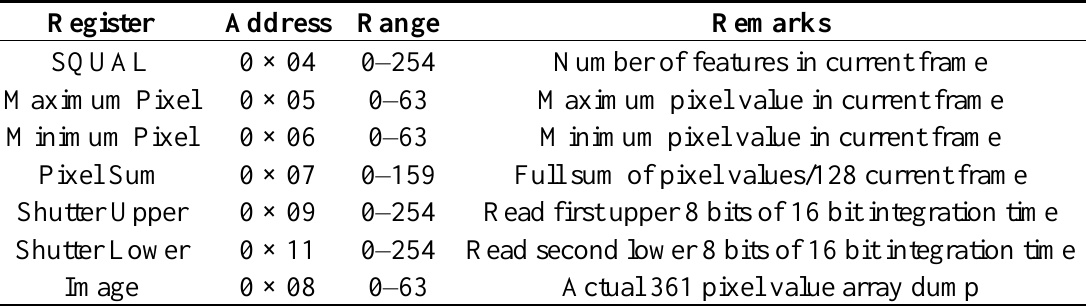
Table 1. Optical mouse sensor data